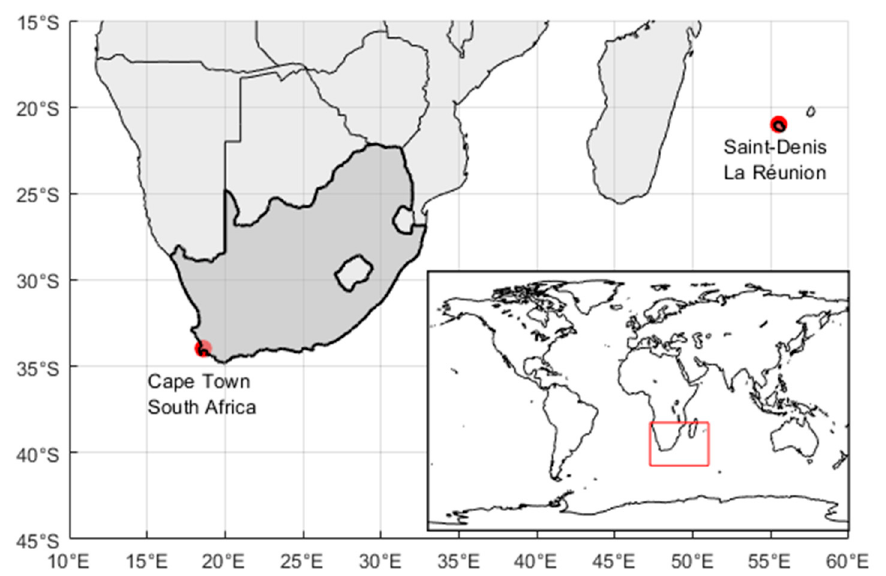
Figure 1. Geographical locations of Saint-Denis and Cape Town ground-based solar ultraviolet radiation (UVR) measurement sites.